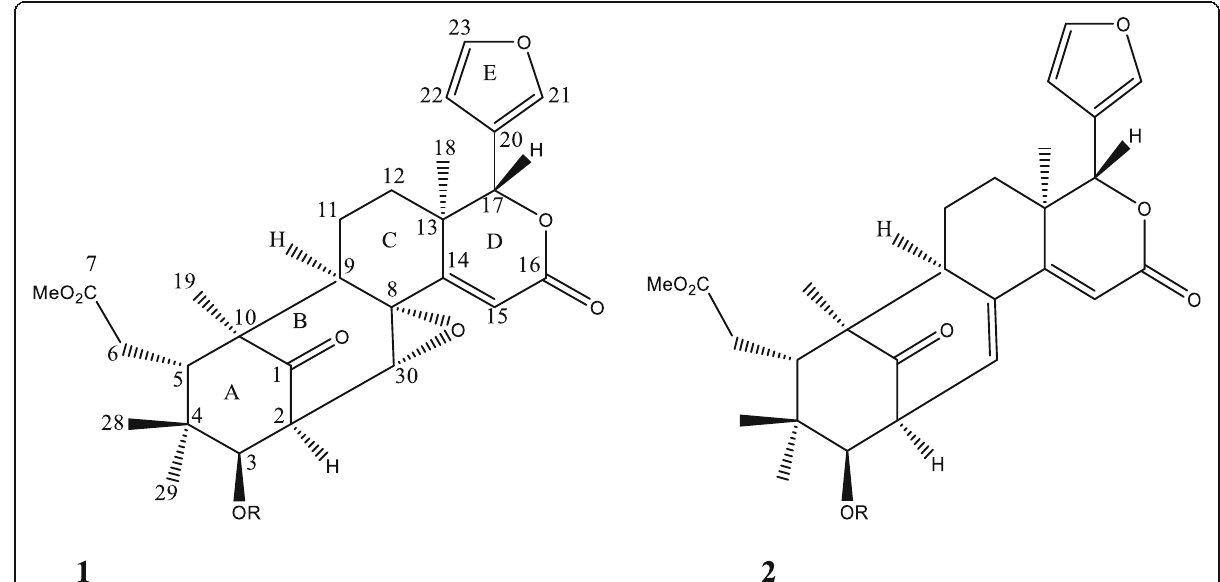
Fig. 6 Structure of limonoids from the fruits of K . ivorensis (1) 14,15-didehydroruageanin A and (2), 3- O -methyl-butyrylseneganolide A. Adapted from [47]